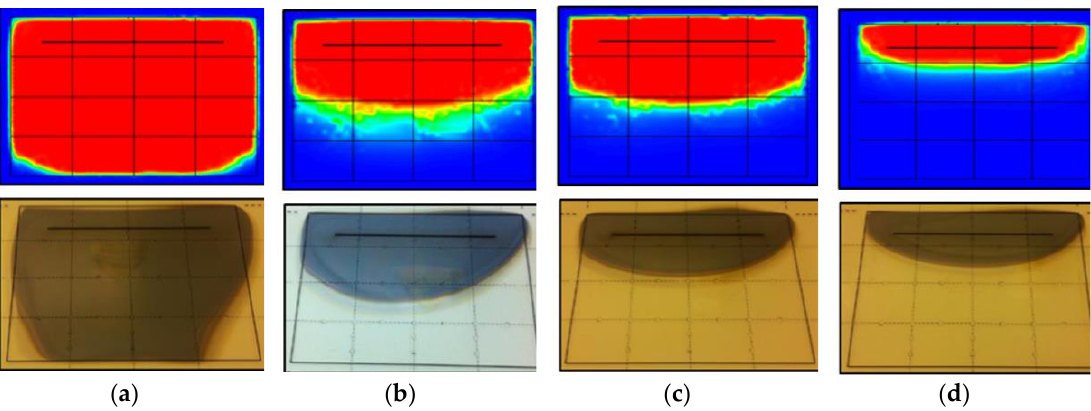
Figure 4. Cadmium Telluride (CdTe) static deposition profiles from experimental samples (bottom) and computational fluid dynamics (CFD) simulations (top). Deposition conditions varied from S-1 ( a ) to S-4 ( d ) in sequence, as given in Table 1.